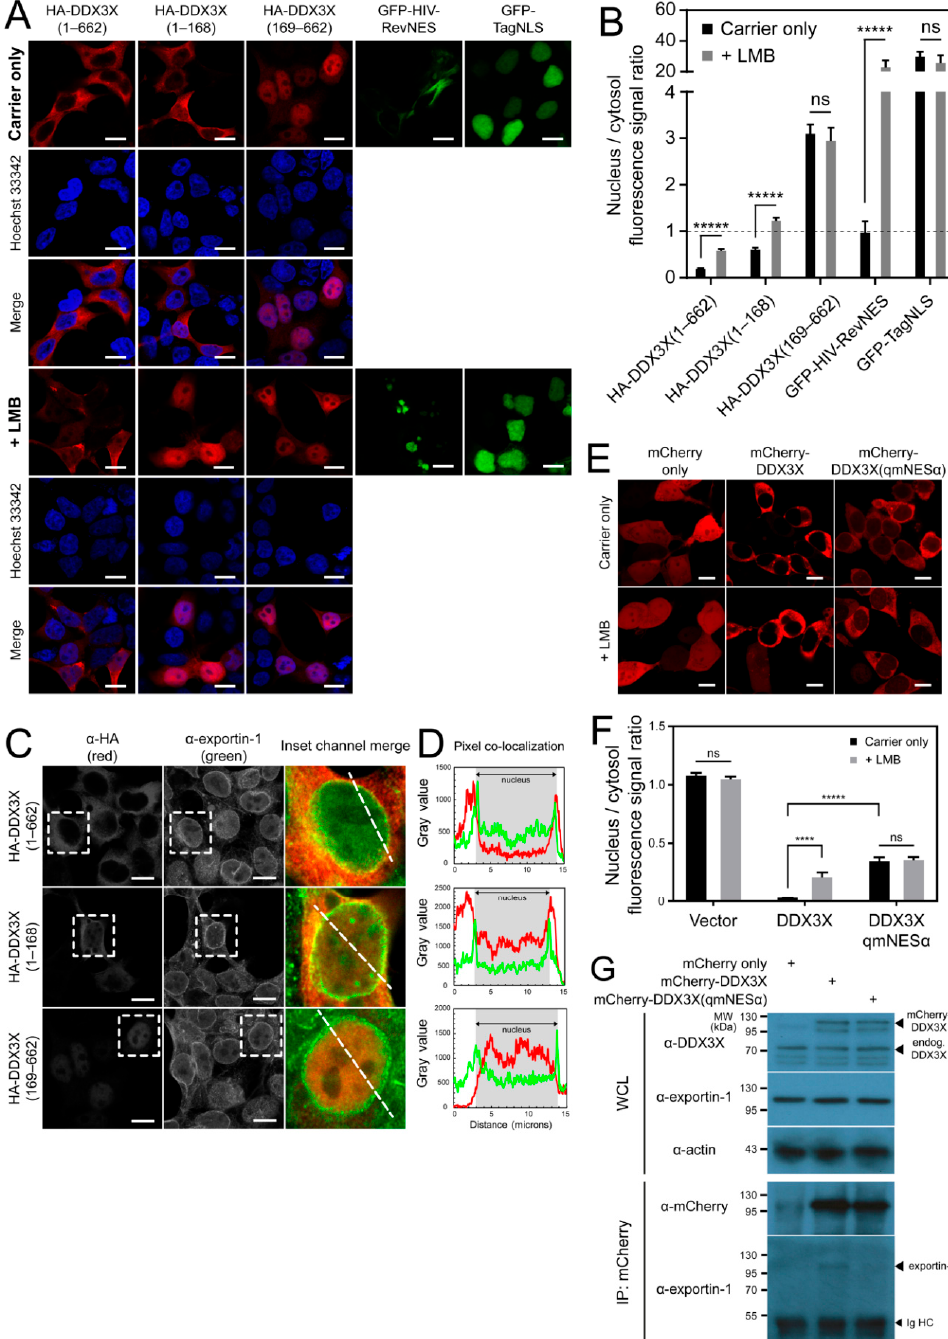
Figure 1. The DEAD-box helicase 3, X-linked (DDX3X) N-terminal region mediates nuclear export by exportin-1. ( A ) Human embryonic kidney (HEK)-293T cells transfected to express HA-DDX3X(1-662), HA-DDX3X(1-168), HA-DDX3X(169-662), GFP-HIV-RevNES or GFP-TagNLS, treated 24 h post-transfection with 20 nM Leptomycin B (LMB) or carrier only (EtOH) for 6 h, then fixed, immunostained using α -HA antibody and DNA counterstained using Hoechst 33342, then visualized by CLSM. Representative cell clusters and channel-merged images shown. Scale bar = 10 µ m. ( B ) Images including those in panel A were analyzed to determine the nucleus / cytosol fluorescence signal ratio. Results represent the mean ± SEM ( n = 50). Student’s t -test with Holm–Sidak multiple comparisons test for significance; *****, p ≤ 0.0001; ****, p ≤ 0.001; ns, not significant. ( C ) HEK-293T cells transfected to express HA-DDX3X(1–662), HA-DDX3X(1–168) or HA-DDX3X(169–662), then fixed